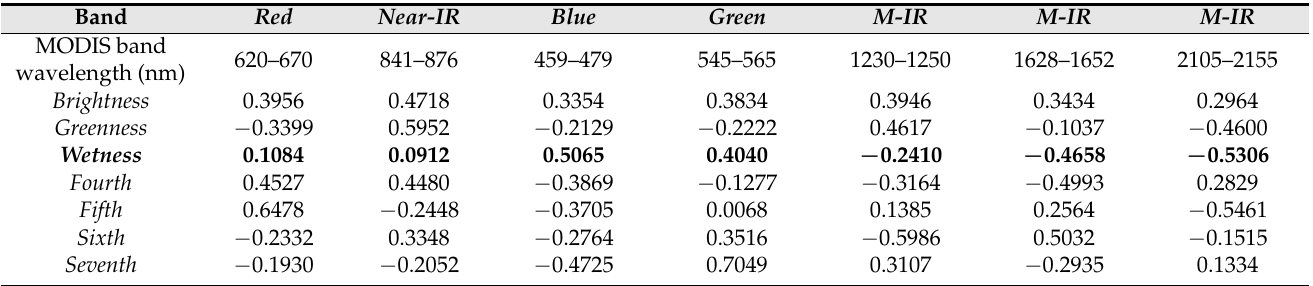
Table A1. Coefficients used in the tasseled cap transformation (TCT) of MODIS NBAR